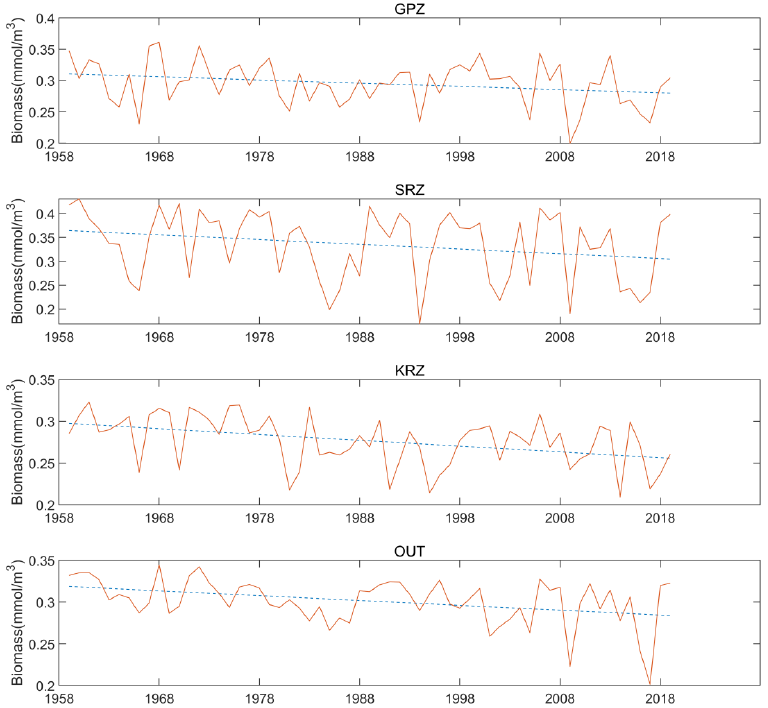
Figure 6. Annual variation of biomass in February in the different MPA regions.